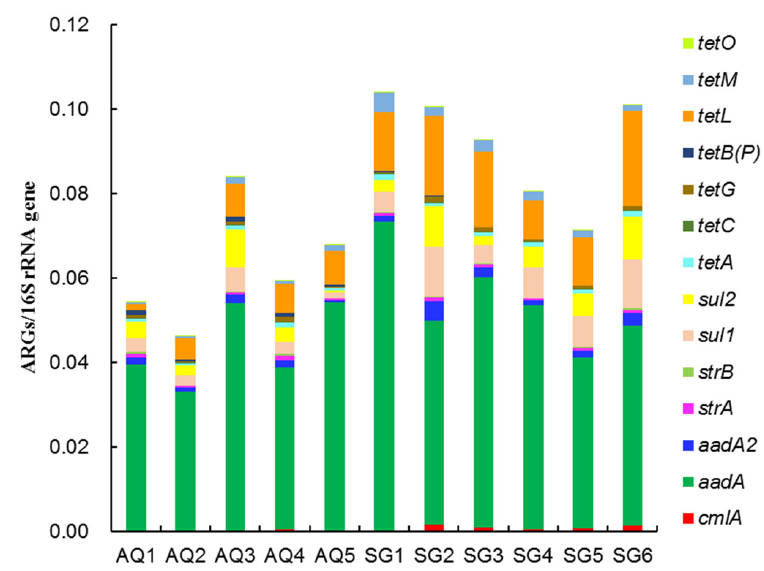
Figure 3. Relative abundances of ARGs in different greenhouse soils.